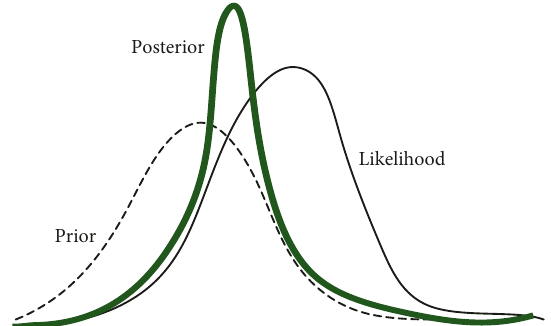
Figure 5: Comparison between importance function samples and real